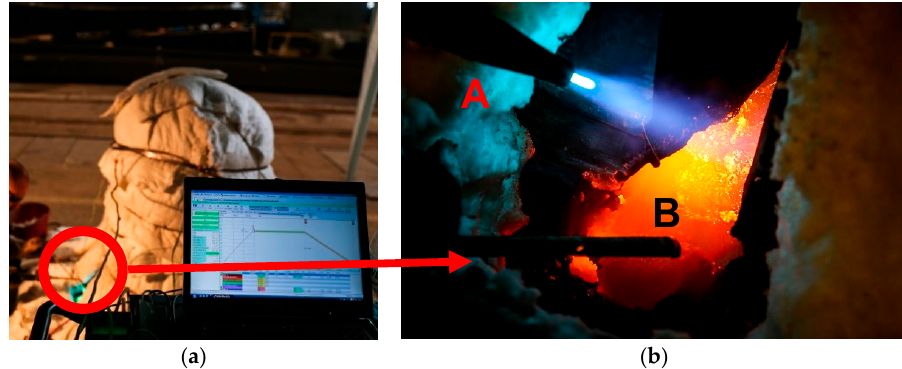
Figure 7. Welding process ( a ) the bell protected by fibro isolation; red circle–the place of welding ( b ) close–up of the place of welding. A—acetylene torch, B—bronze rod. After the cooling process, the place of welding was ground (Figure 8) and the sound of bell was examined.